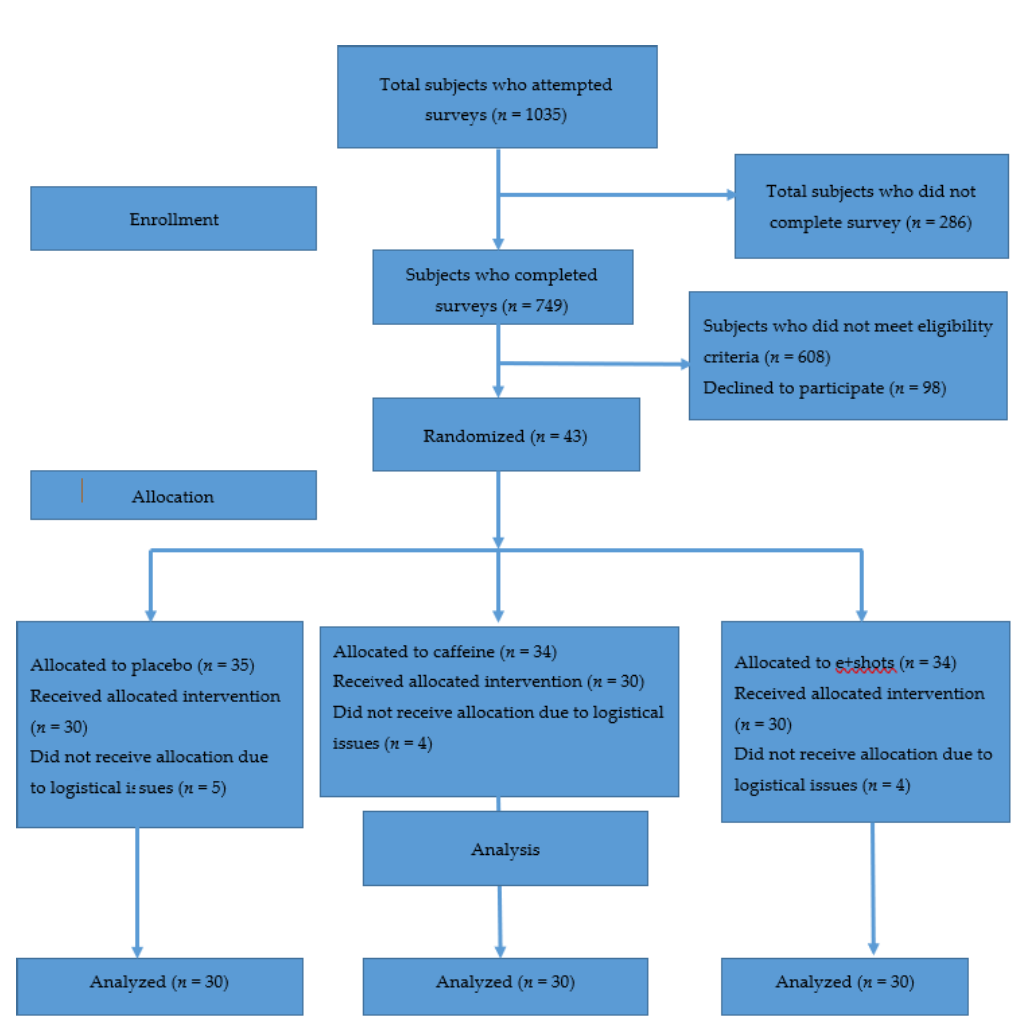
Figure 4. CONSORT flow diagram.